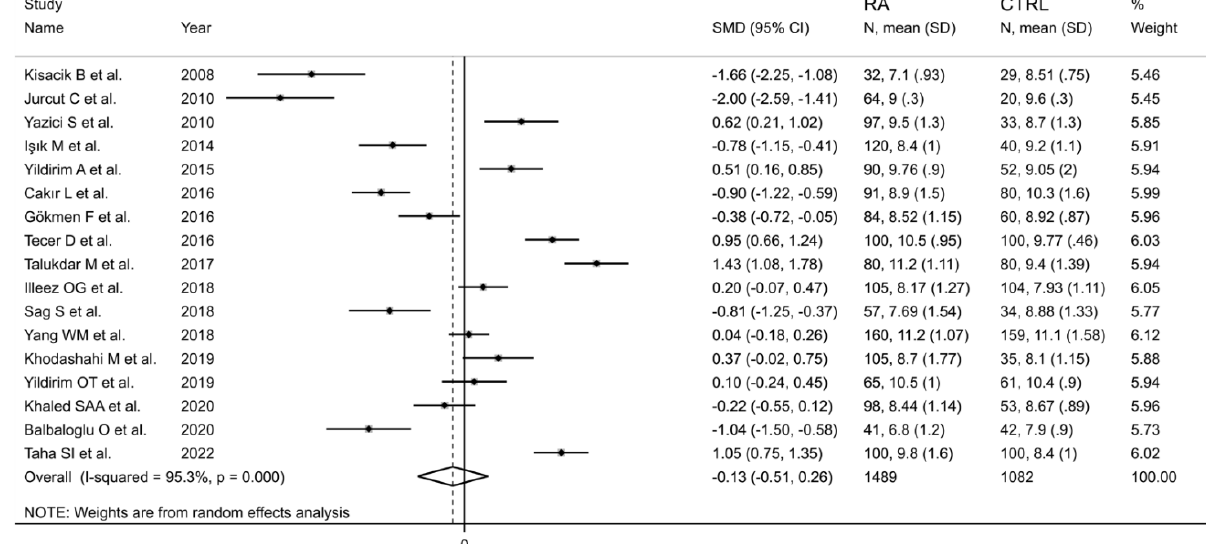
Figure 4. Funnel plot of studies investigating the association between the mean platelet volume and rheumatoid arthritis. Dummy studies and genuine studies are represented by enclosed circles and free circles, respectively. 3.2.5. Subgroup and Meta-Regression Analysis In subgroup analysis, there were no significant differences ( p = 0.522) in SMD be- tween retrospective (SMD = −0.33, 95% CI −0.96 to 0.29, p = 0.30; I 2 = 95.9%, p < 0.001) and prospective studies (SMD = −0.02, 95% CI −0.53 to 0.50, p = 0.95; I 2 = 95.2%, p < 0.001; Figure 5). Similarly, no significant differences ( p = 0.405) were observed between studies con- ducted in Turkey (SMD = −0.27, 95% CI −0.73 to 0.18, p = 0.297; I 2 = 94.2%, p < 0.001) and other countries (SMD = 0.14, 95% CI −0.17 to 0.85, p = 0.23; I 2 = 96.4%, p < 0.001; Figure 6). In univariate meta-regression, no significant associations were observed between the ef- fect size and age (t = 1.33, p = 0.20), pr oportion of males (t = −0.89, p = 0.39), CRP (t = −0.83, p = 0.44), or ESR (t = −1.12, p = 0.30). Conversely, there was a significant association between